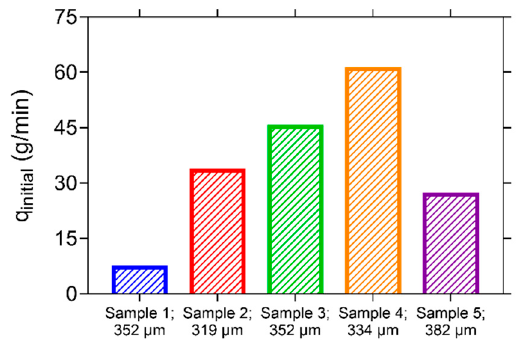
Figure 15. Initial flow rate measured in the water permeability setup for the five di ff erent specimens with an indication of the mean crack width.